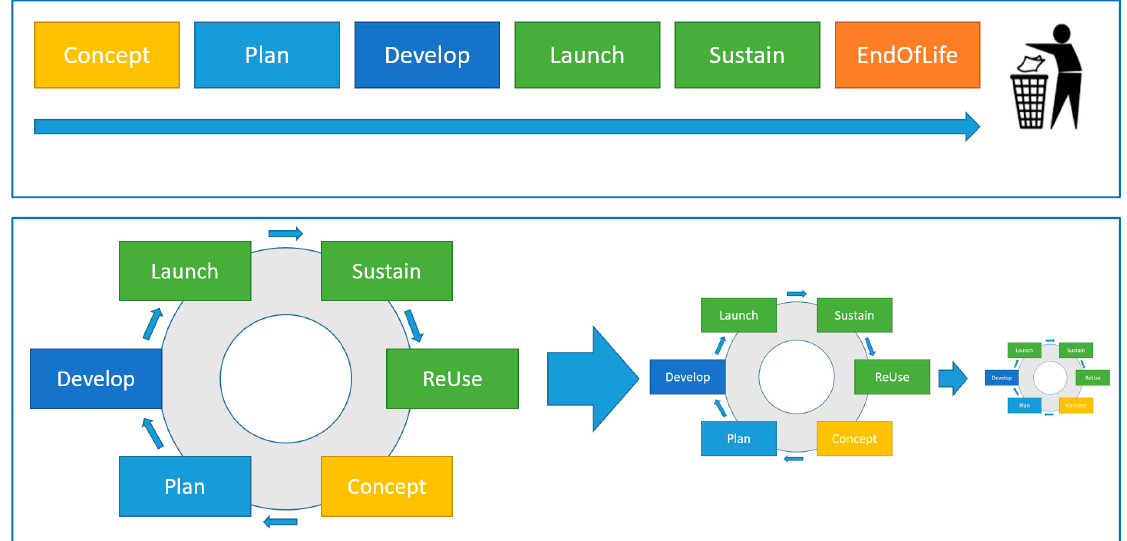
Figure 2. Linear vs. circular information management circle